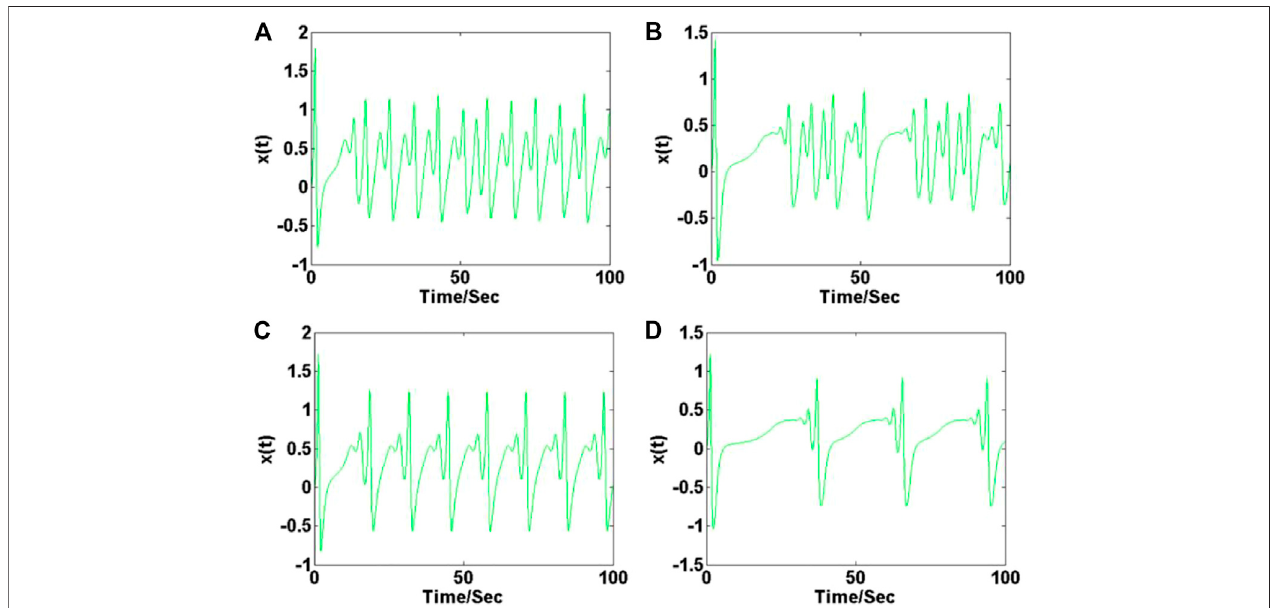
FIGURE 12 | Time series of membrane potential of system (10) with a (cid:1) 2.8, c (cid:1) 1.7, d (cid:1) 2.5 and initial conditions (0, 0, 0): (A) b (cid:1) 5.5, (B) b (cid:1) 6.2, (C) b (cid:1) 9.2, (D) b (cid:1) 11.5.